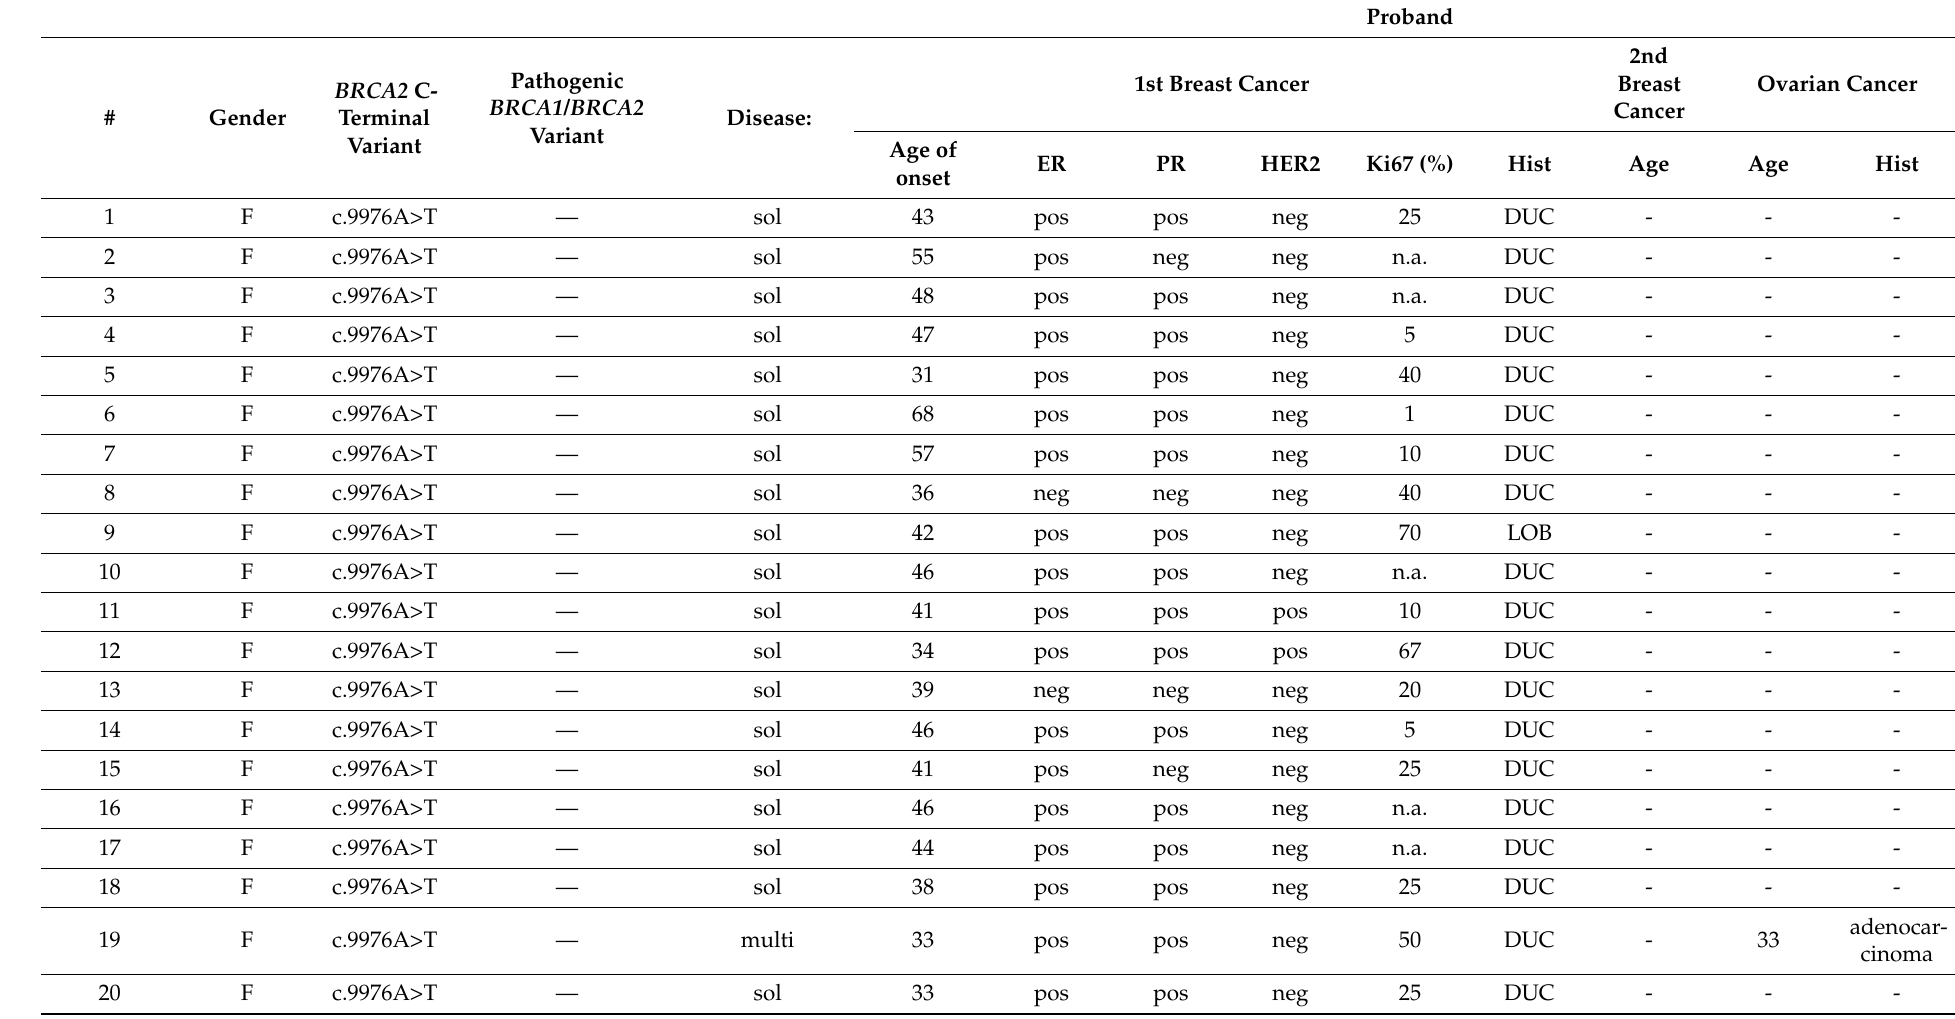
Table 1. Patient characteristics harboring BRCA2 C-terminal variants (LRG_292t1:c.9976A>T, p.(Lys3326Ter) and LRG_292t1:c.10095delinsGAATTATATCT, p.(Ser3366AsnfsTer4)).